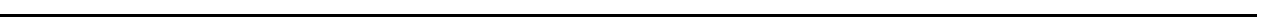
Fig. 2 Characterization of S-phase lncRNAs as oncogenic drivers and independent prognostic markers using pan-cancer TCGA data sets. a Heatmap of 570 S-phase lncRNAs showing signi fi cant differential expression at least in one cancer type from TCGA. The signi fi cance was considered based on log-fold change ± 2 and FDR < 1E – 004 (Benjamini – Hochberg ’ s method). The highlighted lncRNAs are the ones selected for functional validation. The plot on the left side shows the frequency of individual lncRNAs differentially expressed across different cancer types. b Venn diagrams illustrating the overlap between common S-phase lncRNAs which are differentially expressed in different types of kidney and lung cancers. c Heatmap of S-phase lncRNAs with anti- correlative promoter methylation status to the differential expression levels in corresponding cancer. Hypomethylated promoter associated with higher expression and hypermethylation to less expression compared to normal. The highlighted lncRNAs are differentially methylated in more than 100 patients (samples) supporting the methylation pattern in corresponding cancer. Box plots of highlighted lncRNAs denoting the anti-correlative relation between promoter methylation and transcript expression. Box plots middle line shows the median, the box limits are 25th and 75th percentiles, whiskers are nearer quartile ± 1.5 times interquartile range and points beyond whiskers are the outliers. The p -values for the comparisons were obtained using Mann – Whitney test and corrected p -values using Family Wise Error Rate (FWER). The signi fi cant differentially methylated regions were fi ltered on the basis of FWER < 0.05. The above information for statistical analysis was extracted from COSMIC repository. d Heatmap showing the potential independent prognostic values of 520 S-phase lncRNAs based on dichotomization approach. The red color indicates higher expression of lncRNAs that predicts poor survival outcome. The blue color indicates lower expression of lncRNAs associated with poor survival in patients. e Venn diagrams indicating the numbers of S- phase lncRNAs that independently predict the survival outcome in different types of kidney and lung